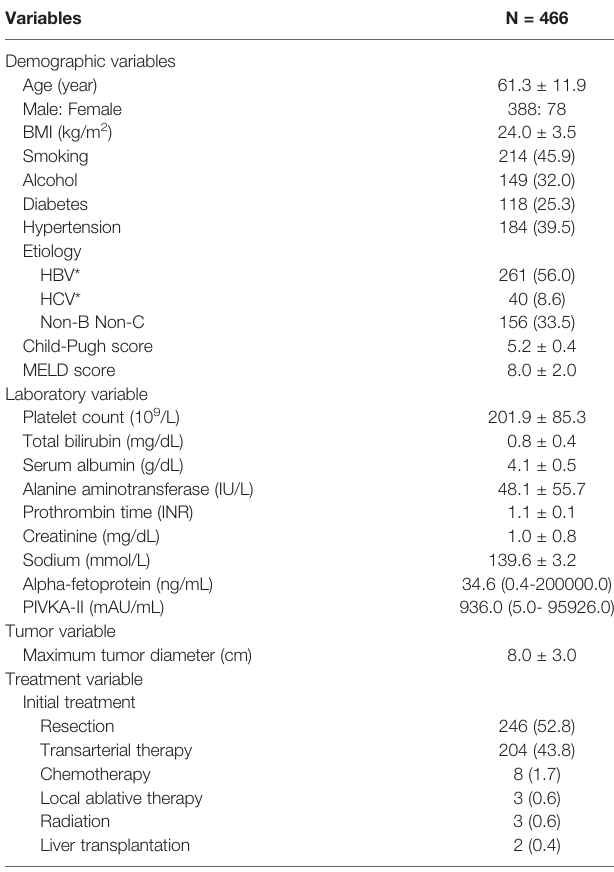
TABLE 1 | Demographic and clinical characteristics of the included patients. Variables